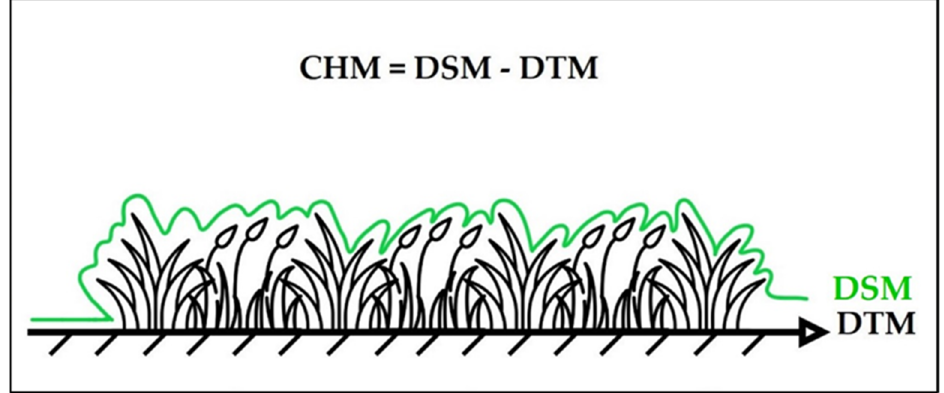
Figure 7. Graphical illustration of relation between digital surface model (DSM), digital terrain model (DTM), and canopy height model (CHM).